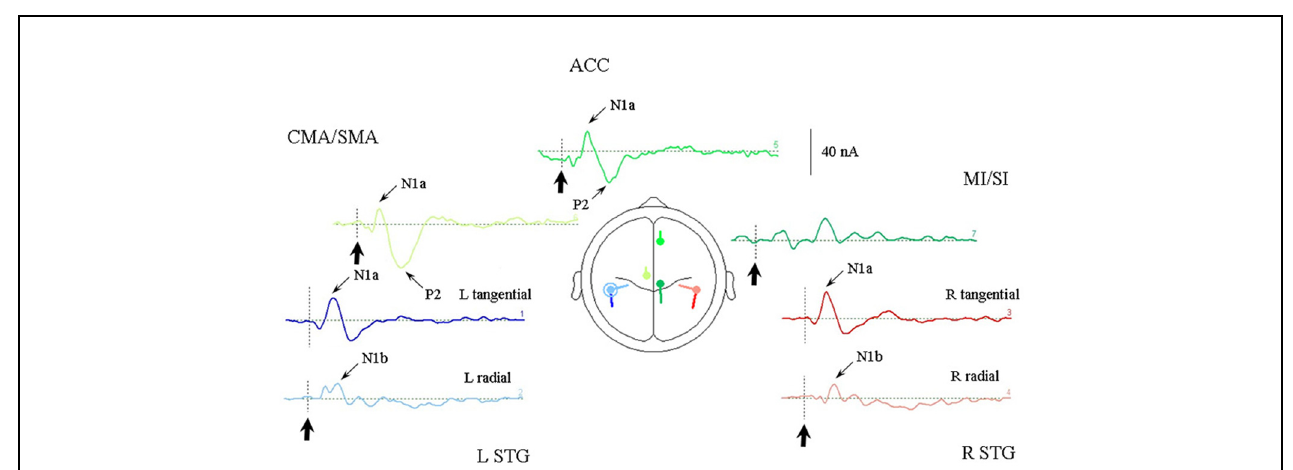
distinguished by light red. Left hemisphere STG sources are in blue, with the radial source distinguished by light blue. (A) Standard MRI images centered on the CMA/SMA source. (B) Standard MRI images centered on the right STG sources. (C) A BESA representation of the sources shown from left sagittal, superior and posterior perspectives. (D) A BESA representation of the sources shown from right sagittal, inferior and frontal perspectives.